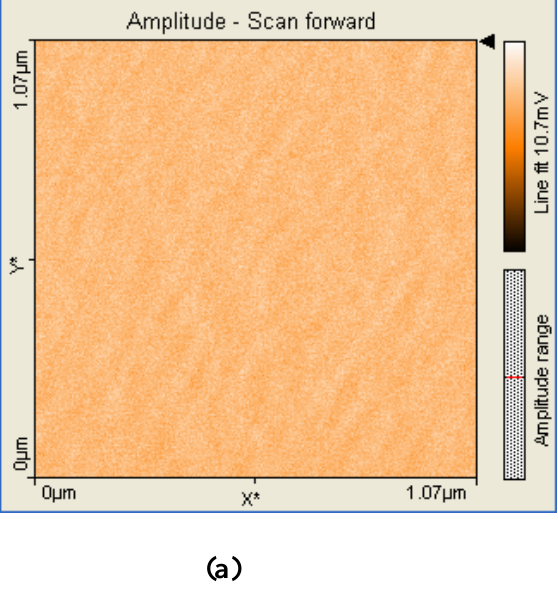
Figure 15. 2D (a) and 3D (b) AFM images (1.07×1.07µm) and particle analysis of the hybrid material 1a-A